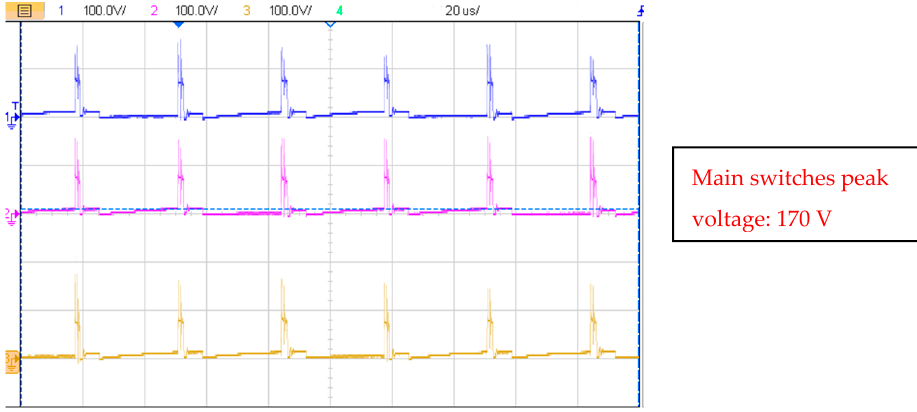
Figure 20. Experimental waveforms. Drain-source voltage: main switch 1 (blue), main switch 2 (pink), and main switch 3 (yellow); scale: 100 V/div. Base time 20 µs/div. Figure 19. Experimental waveforms. PV panels’ currents: PV panel 1 (blue), PV panel 2 (pink), and PV panel 3 (yellow); scale: 10 A/div. Converter’s output current (green); scale: 5 A/div. Base time: 200 µs/div.